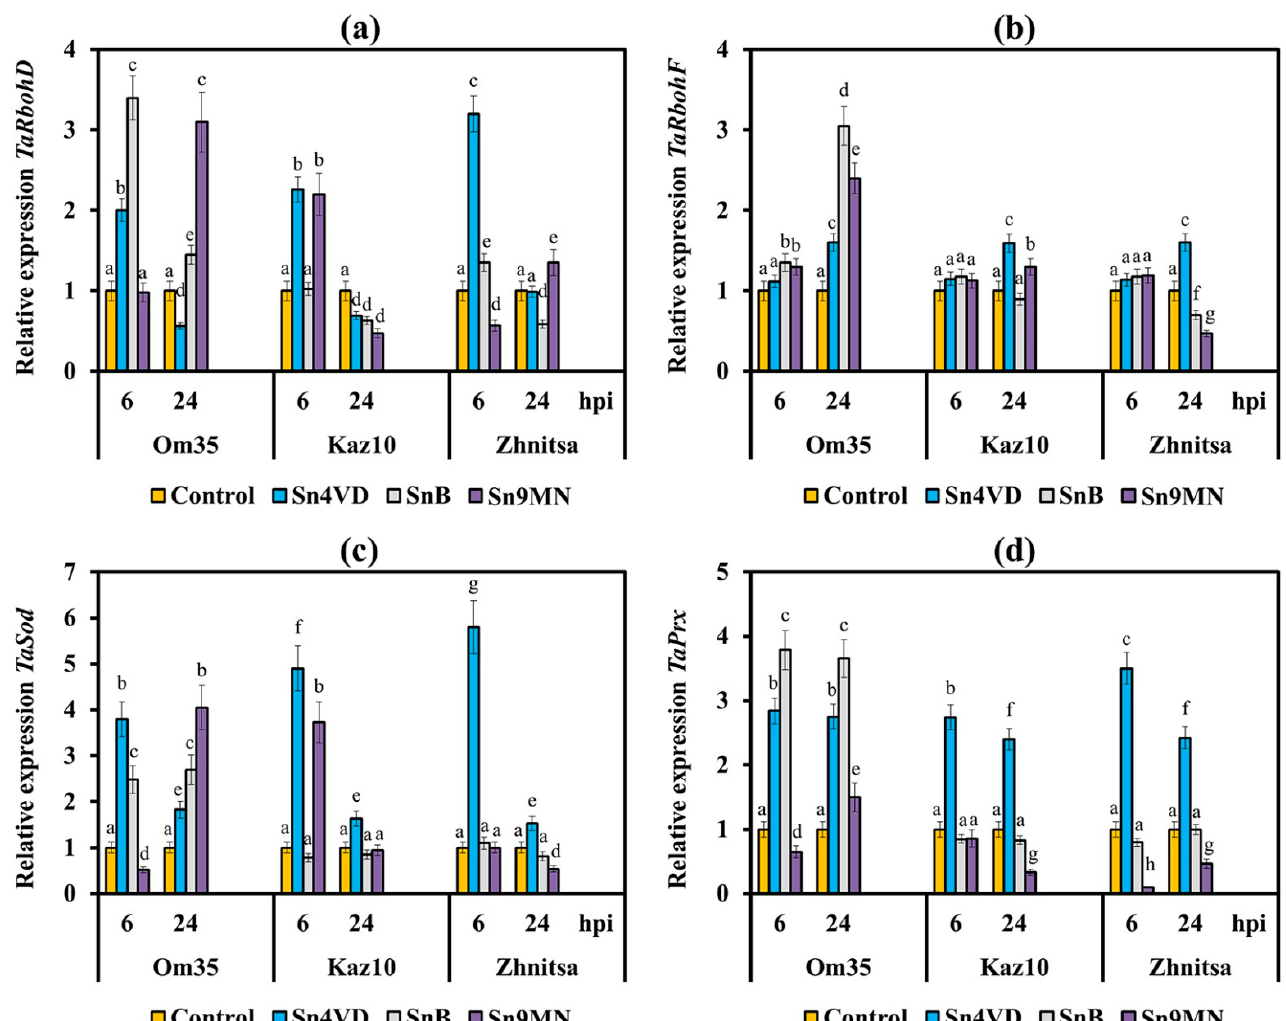
Figure 5. The relative expression of genes encoding isoforms of wheat NADPH oxidase, RBOHD and RBOHF, as well as superoxide dismutase and anionic peroxidase in three wheat cultivars Om35, Kaz10 and Zhnitsa 6 and 24 h post-inoculation (hpi) with S. nodorum isolates Sn4VD, SnB and Sn9MN. ( a ) The mRNA level of the TaRbohD gene. ( b ) TaRbohF gene. ( c ) TaSod gene. ( d ) TaPrx gene. Expression values were normalized to the housekeeping gene TaRLI as an internal reference and presented relative to the normalized expression levels in mock-treated control plants (Control). The samples are indicated as follows: Control—non-infected plants; Sn4VD—plants infected with isolate Sn4VD; SnB—plants infected with isolate SnB; Sn9MN—plants infected with isolate Sn9MN. Means ± SE (n = 6) marked with similar Latin letters do not differ significantly according to the LSD-test ( p ≤